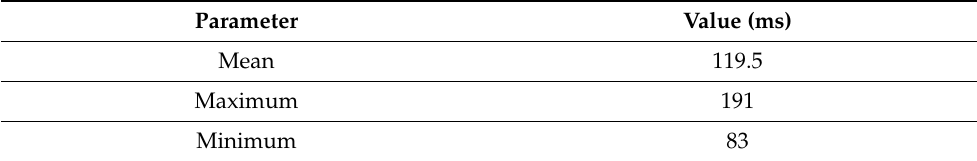
Table 2. Summary of